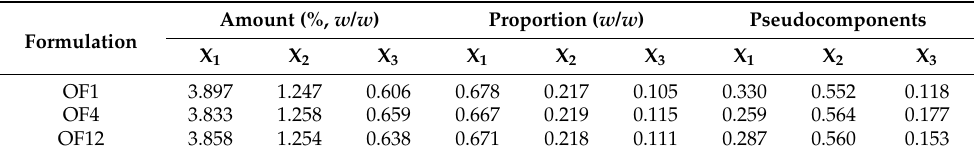
Table 3. Optimized formulations (OF) of NLC containing Palmarosa essential oil proposed by the Scheffe’s special quartic-order model.